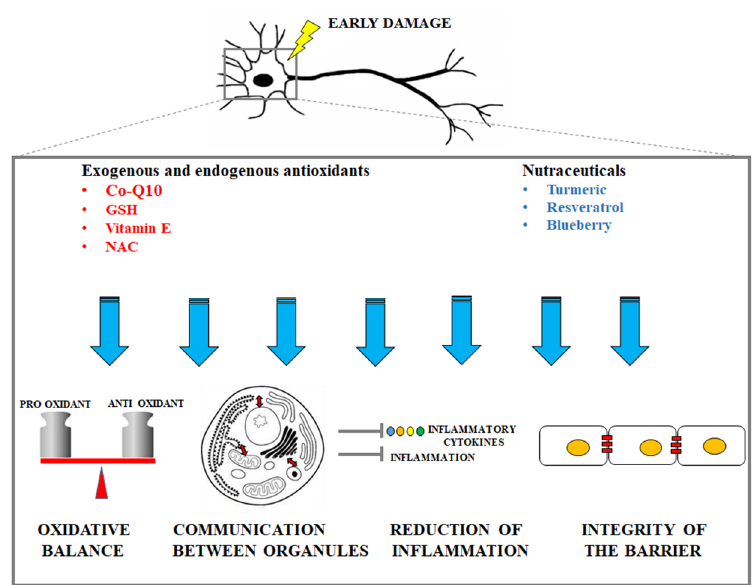
Figure 2. Description of the main protective mechanisms by exogenous antioxidants and nutraceuticals in early neuronal damage.